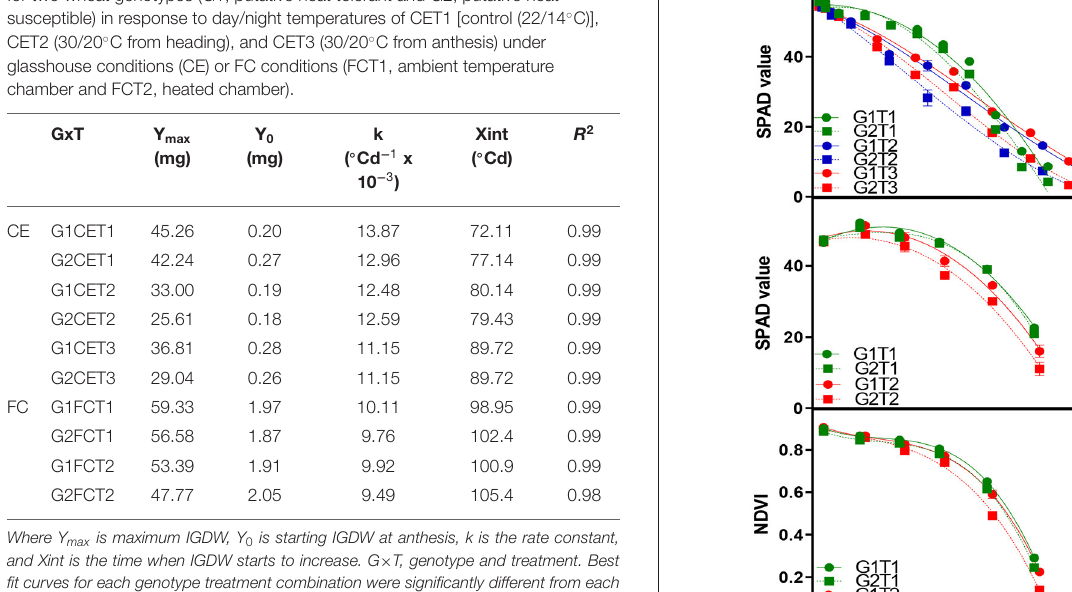
TABLE 4 | Parameters of the logistic curves fitted to IGDW over time in Figure 2 for two wheat genotypes (G1, putative heat tolerant and G2, putative heat susceptible) in response to day/night temperatures of CET1 [control (22/14 ◦ C)], CET2 (30/20 ◦ C from heading), and CET3 (30/20 ◦ C from anthesis) under